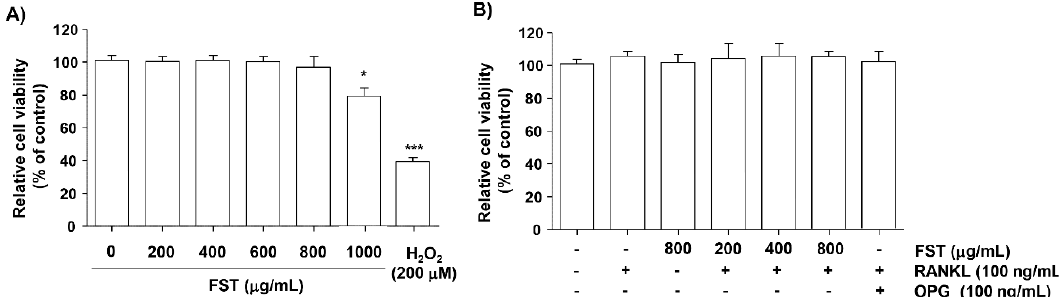
Figure 1. Effects of fermented sea tangle extract (FST) and receptor of activator of nuclear factor kappa-B ligand (RANKL) on the viability of RAW 264.7 mouse macrophage-like cells. Cells were treated with desired concentrations of FST in the absence ( A ) or presence ( B ) of 100 ng/mL RANKL and/or 100 ng/mL OPG for 72 h. H 2 O 2 was used as a positive control. Cell viabilities were measured by 3-(4,5-dimethylthiazol-2-yl)-2,5-diphenyltetrazolium bromide (MTT) assay. Relative cell viability is expressed as percentages compared to treatment of naïve control cells. Results are presented as means ± SD of three independent experiments. * p < 0.05 and *** p < 0.005 indicates significant difference compared to the untreated control cells. OPG: osteoprotegerin; +: cells treated the reagent; -: cells untreated the reagent.